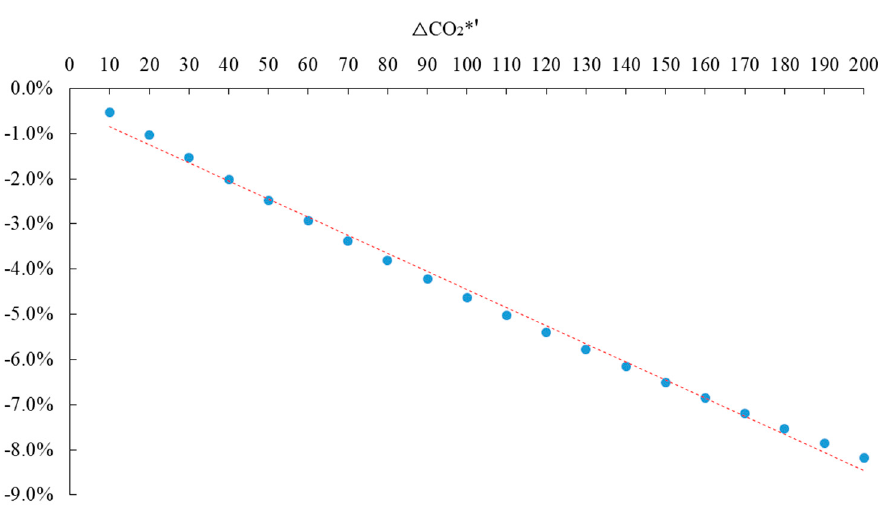
Figure 8. Different rates of carbon tax and the change rate of carbon dioxide emission. The relationship between the rate of carbon tax (T*) and the change rate of carbon dioxide emission can be fitted by EXCEL scatter diagram, trend line analysis, and Eviews software, as shown in Equation